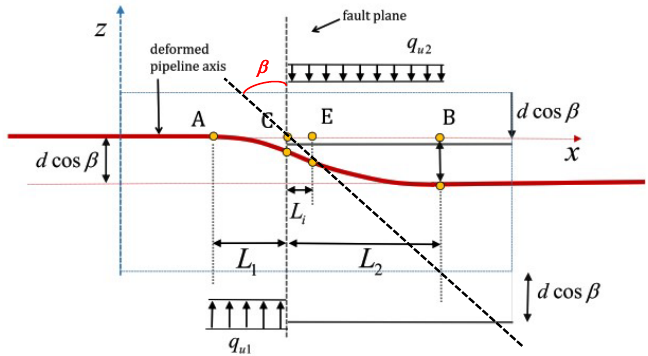
Figure 1. Schematic shape of pipeline curvature at active fault zone [10].